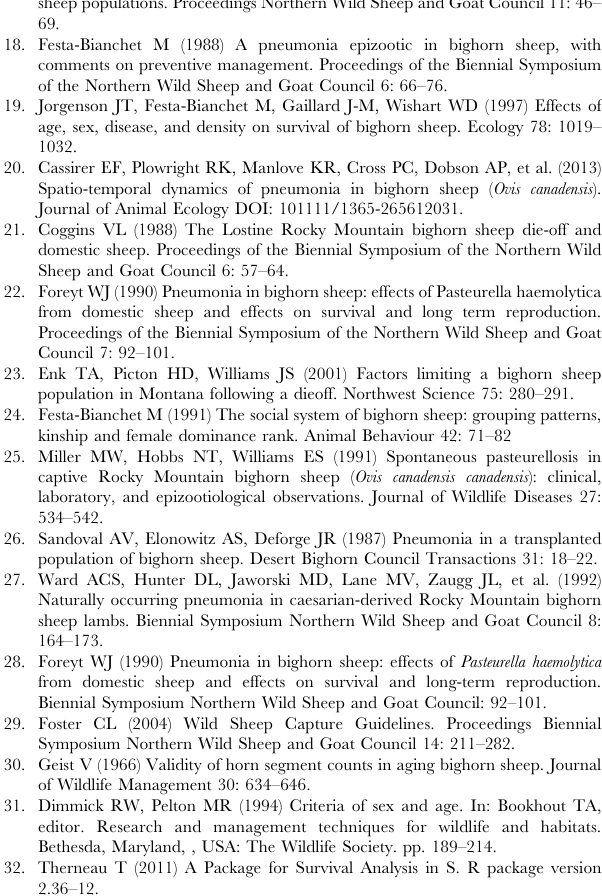
Figure S2 Ewe pneumonia survival probability as a function of age. The shaded area represents the 95% confidence bounds for the probability that a ewe of a given age died of pneumonia, using data included in the age-based proportional hazards models of ewe pneumonia mortality. Inclusion of an